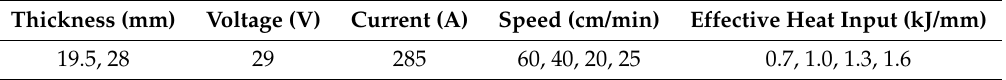
Figure 9. Specimen of the V-groove multi-layer welding for algorithm validation; root gap: 4 mm, root face: 0 mm, thickness: 28 mm. Table 3. Welding conditions for V-groove butt